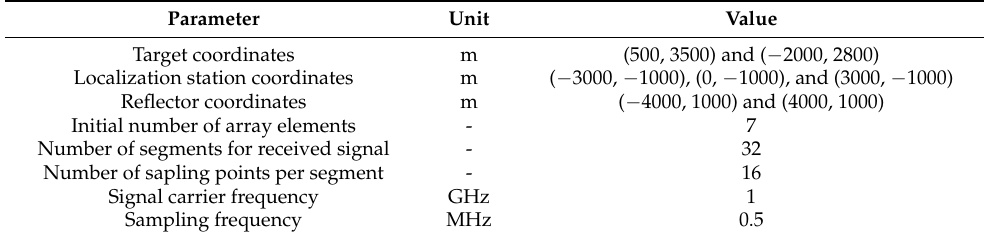
Table 3. Simulation